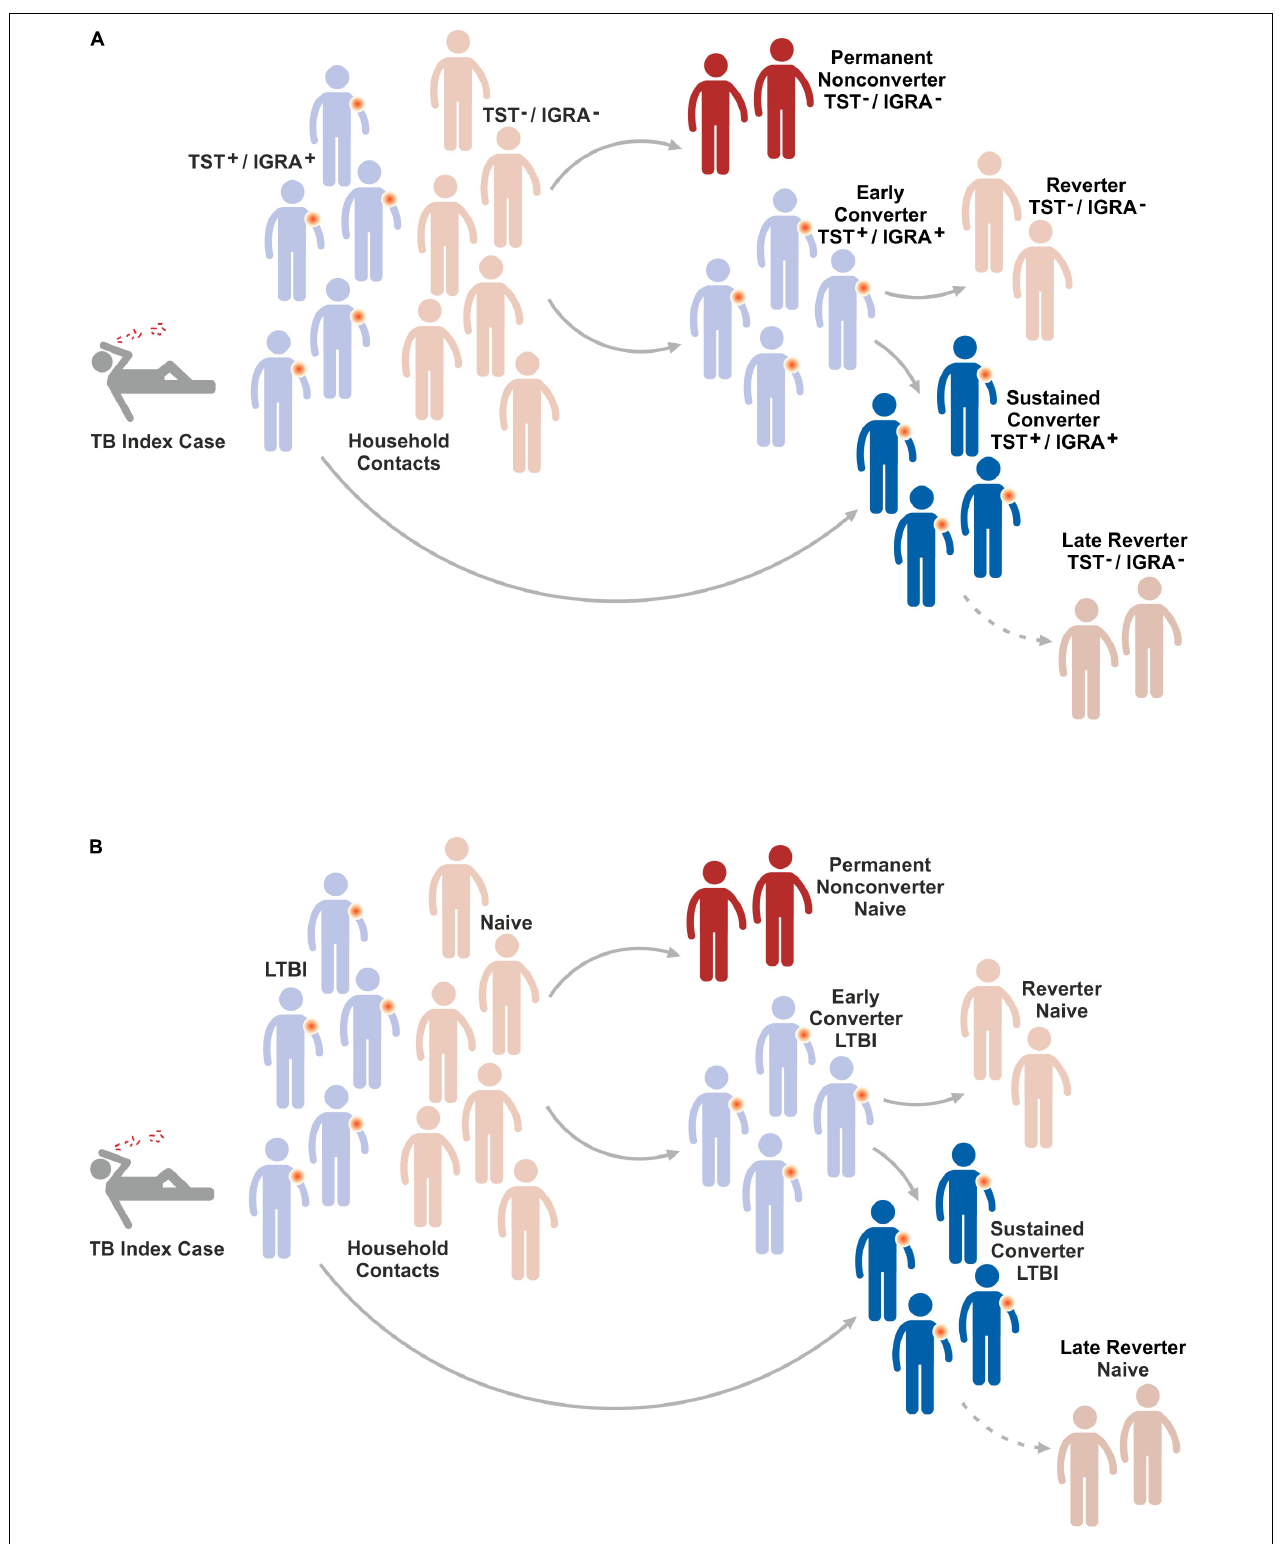
FIGURE 4 | Fate of household contacts of a TB index case. Household contacts of a TB index case are either already latently TB infected (LTBI) or do not show evidence for immunity against Mtb infection. After sustained contact with a TB index case, the majority of naïve individuals will rapidly convert to LTBI because they